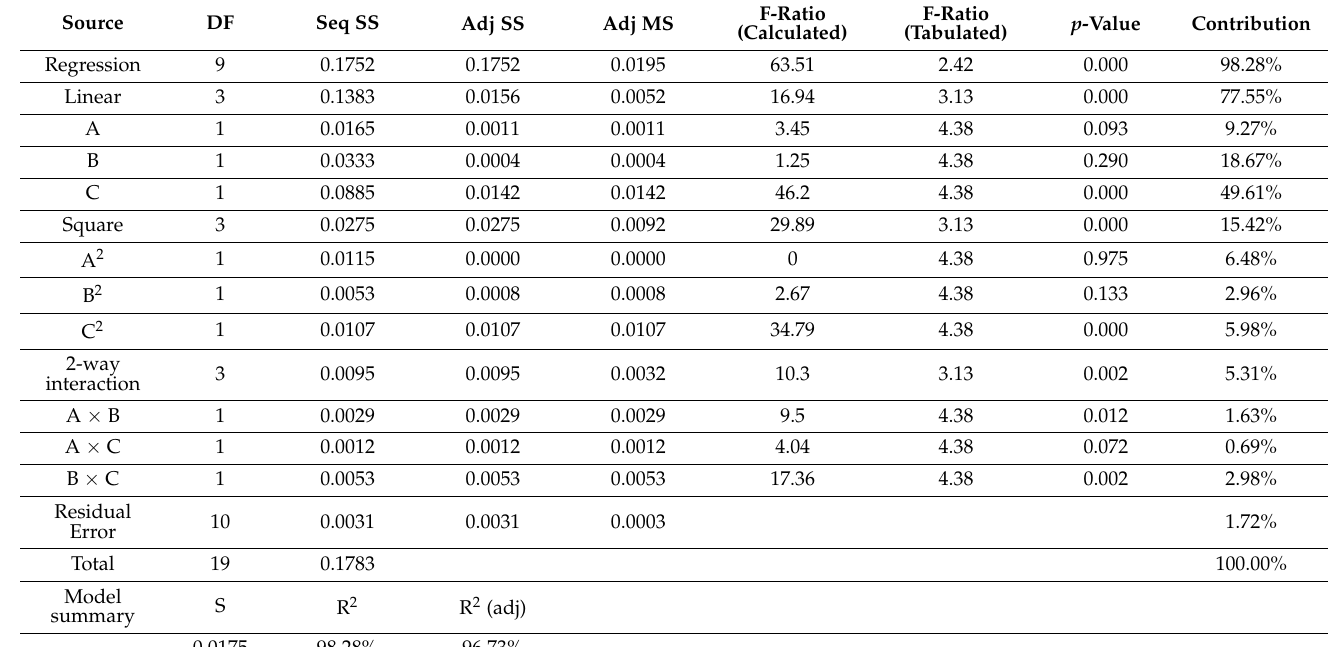
Table 9. ANOVA for delamination factor of carbon fabric-neat epoxy.